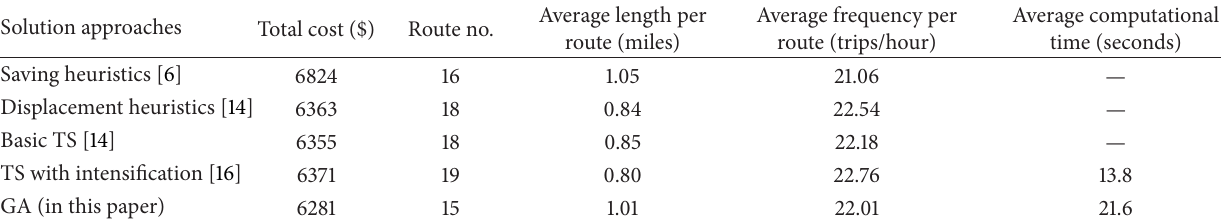
Table 3: Comparison of the best solutions.